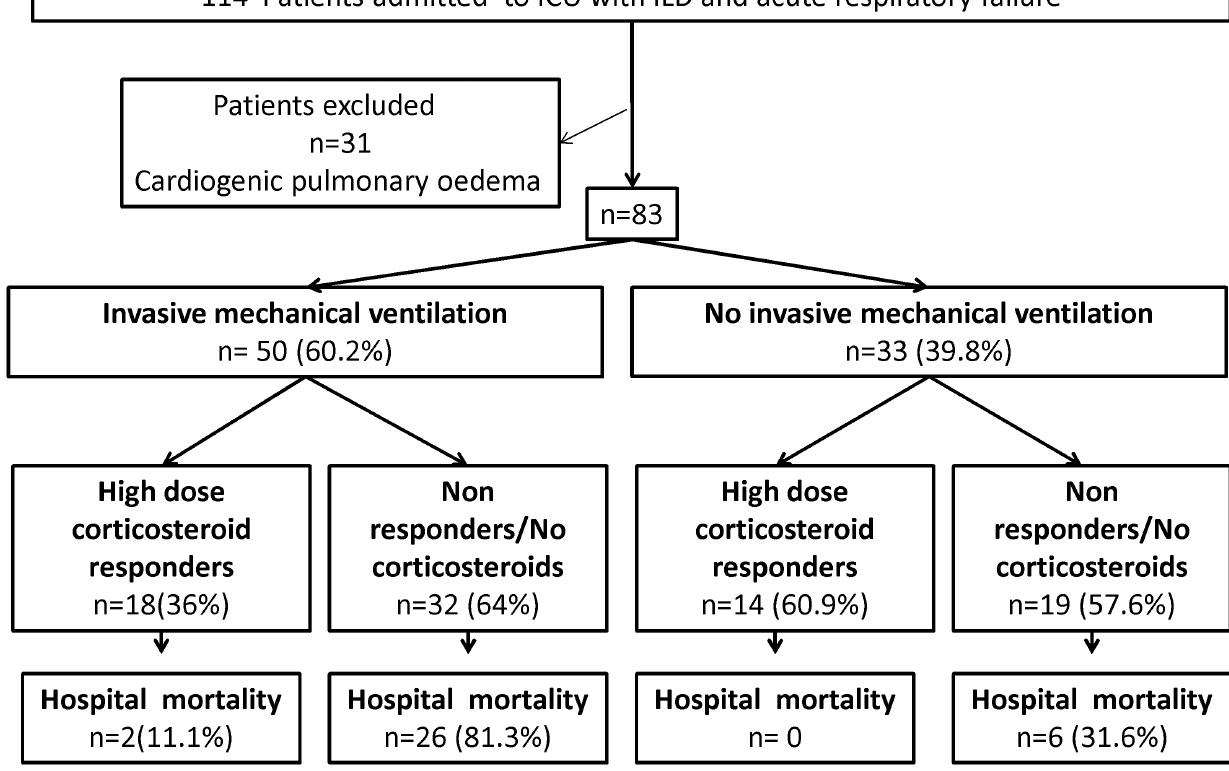
Figure 1. Flow chart of patients admitted to the ICU between 2002 and 2013 for acute respiratory failure and interstitial lung disease.